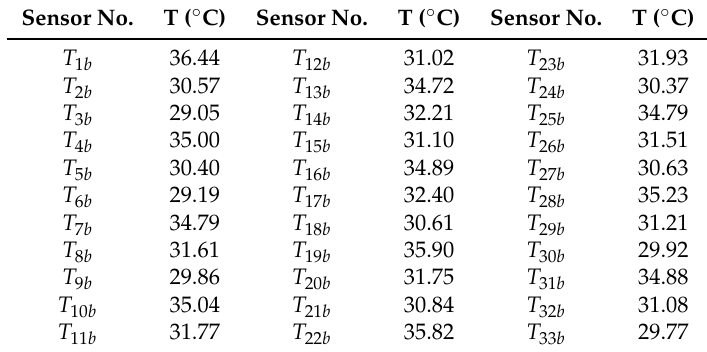
Table A2. Results of temperature measurements, 2D, mechanical ventilation. Sensor No. T ( ◦ C) Sensor No.